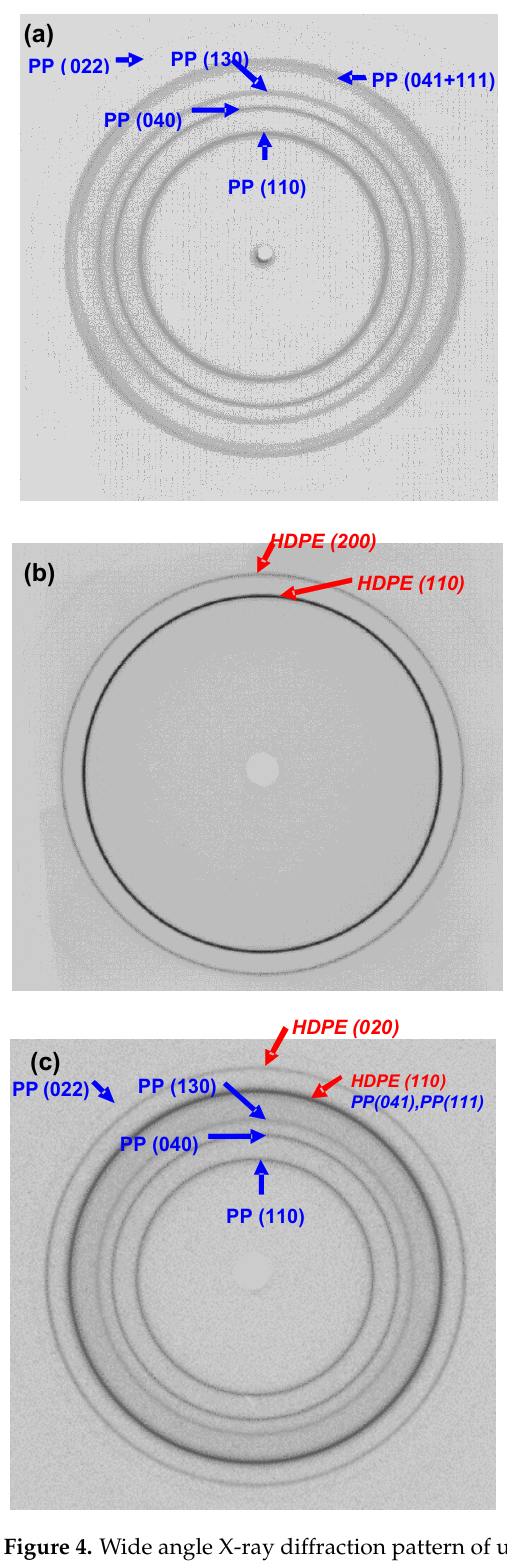
Figure 4. Wide angle X-ray diffraction pattern of unoriented ( a ) PP control tape; ( b ) HDPE control tape; ( c ) 50/50 PP/HDPE tape.